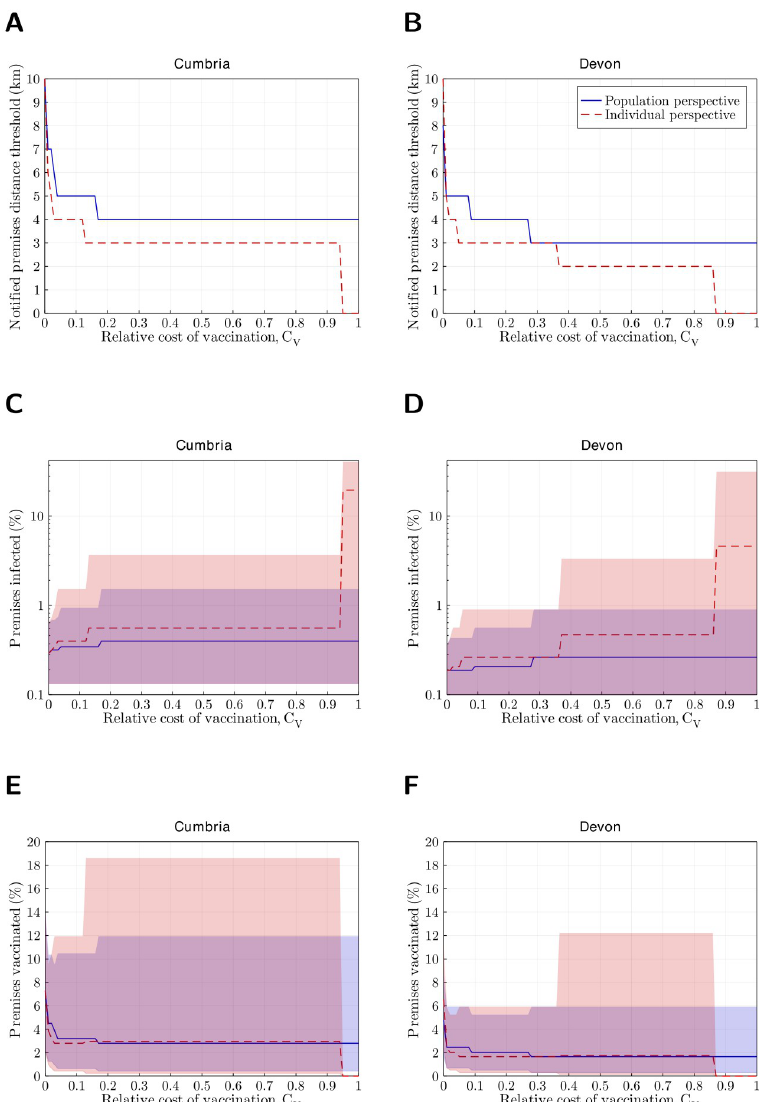
Fig 2. For the ‘default’ pathogen, the reactive vaccination strategy that minimises the overall cost from either the population or individual perspectives, dependent upon the relative cost of vaccination versus infection. We performed 500 replicates per scenario. Vaccination at a premises was triggered by notification of infection within the specified distance threshold (no premises were initialised as either having already been vaccinated or in the ‘never vaccinate’ group). We identified the lowest median cost (with there being a distribution of costs from the ensemble of stochastic simulations) across the control scenarios from a population perspective (blue solid line) and an individual (farmer) perspective (red dashed line) for: A Cumbria; B Devon. We recall that the possible reactive vaccination distance thresholds were 0km to 10km inclusive (in 1km increments). Therefore, as it was not possible for intermediate distances between these integer values to be optimal, we obtained step-like line profiles. Under the identified optimum reactive vaccination strategy, we show medians (lines) and 95% prediction intervals (shaded regions) for: C,D the percentage of premises infected (note the y-axis is on a log scale); E,F the percentage of premises